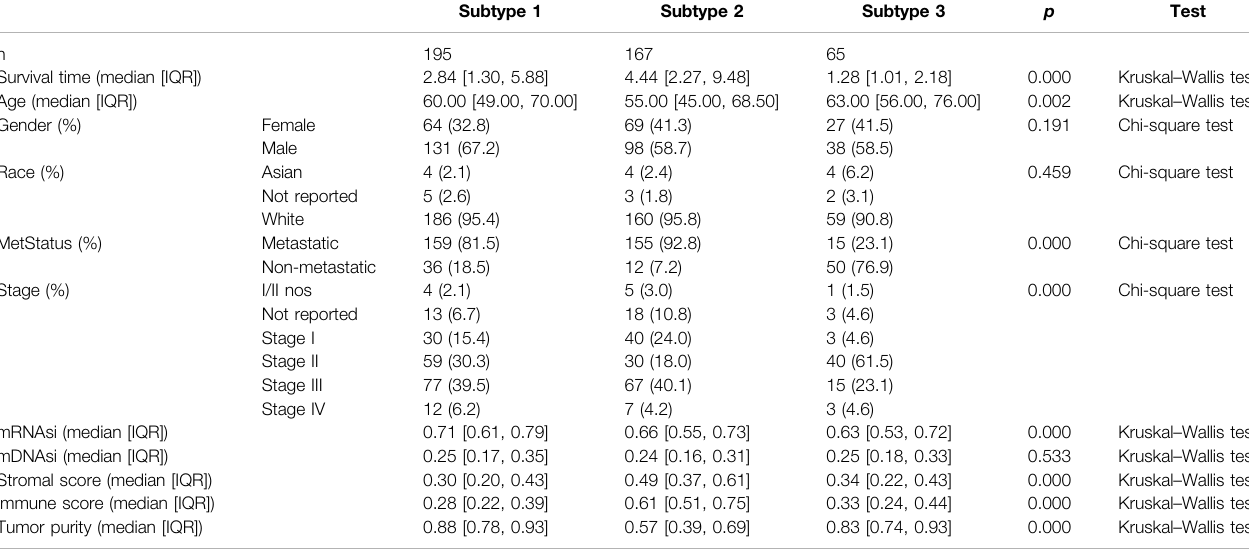
TABLE 1 | Clinicopathological variables of subtypes in melanoma. IQR means interquartile